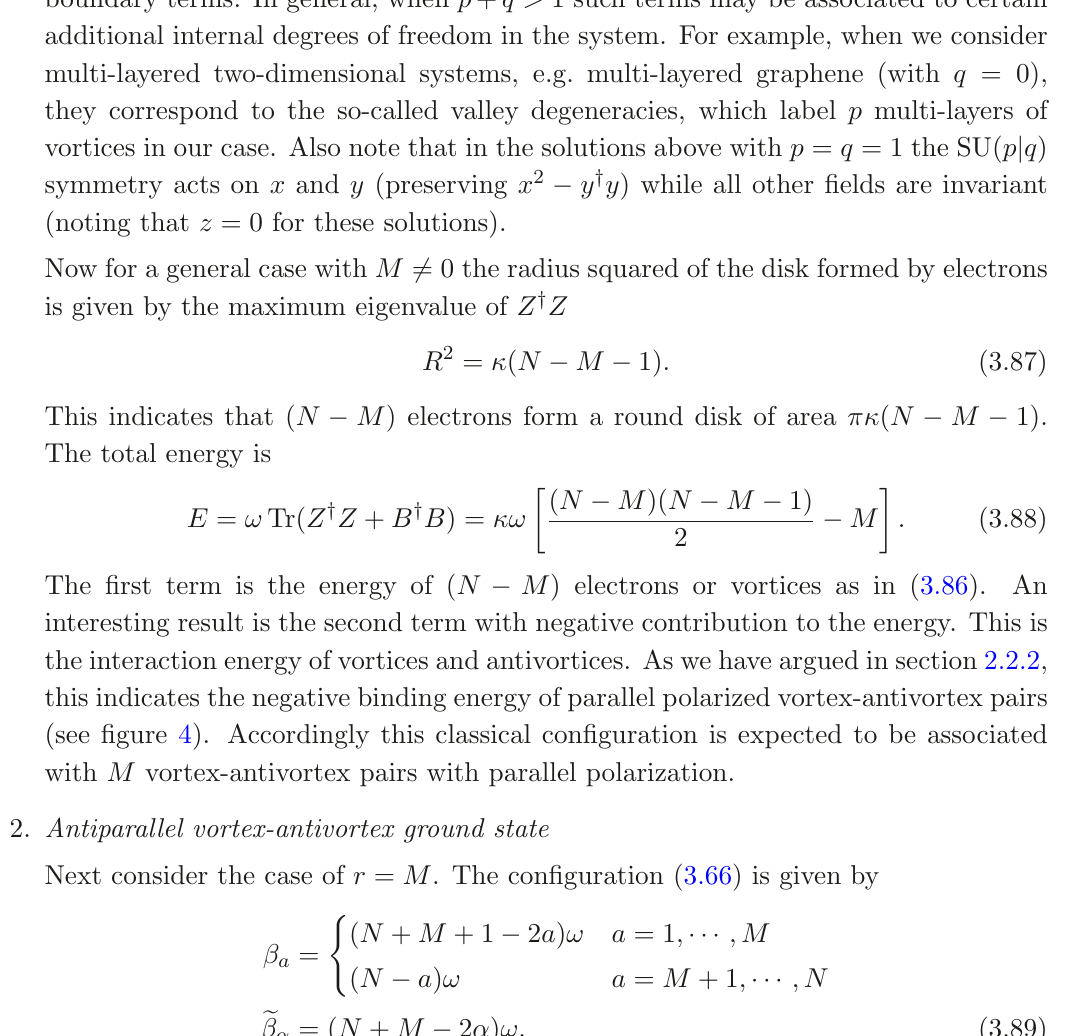
Figure 4 . Parallel polarized vortex-antivortex pair ground state. ( N radius κ ( N M ). M vortex-antivortex pairs are created and the cores of vortices and antivortices − approach each other on spiraling orbits and meet in the p